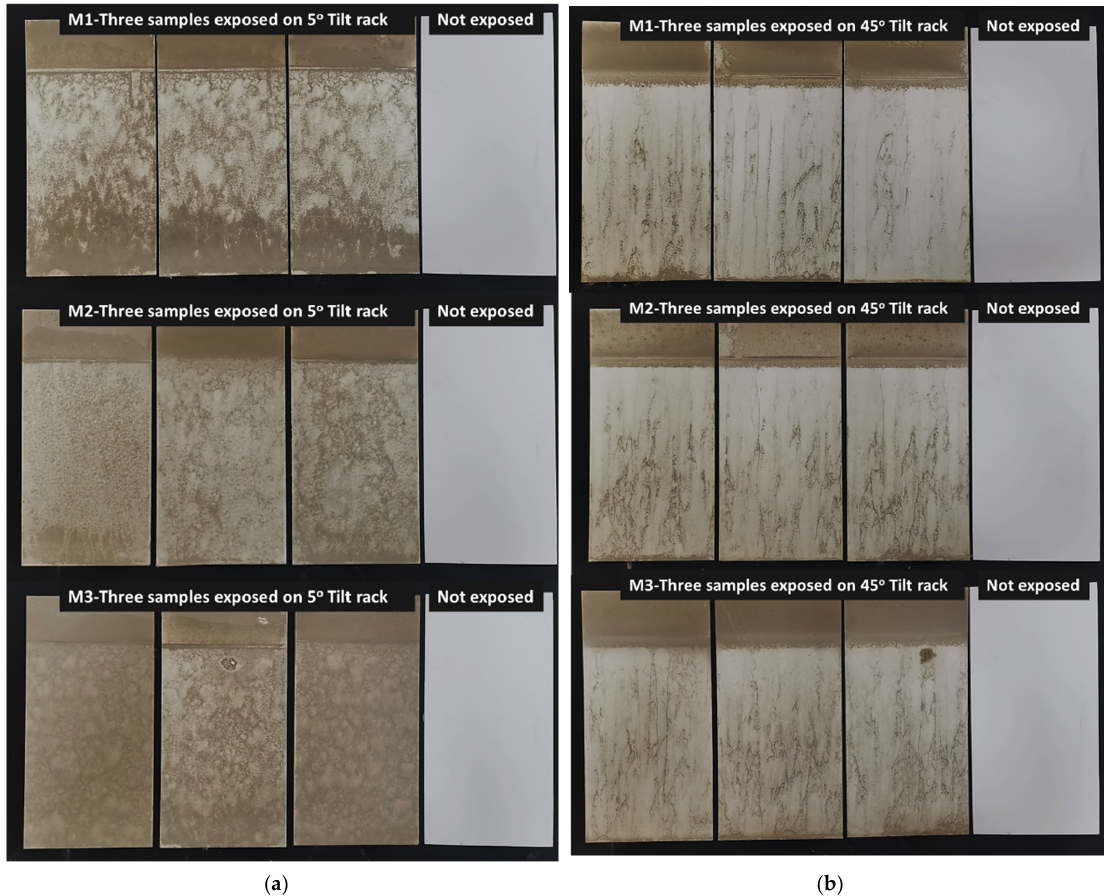
Figure 7. Triplicate samples of various manufacturers after 3 years of natural aging at Ras al Khaimah: ( a ) 5° tilt and ( b ) 45° tilt. ( a ) 5 ◦ tilt and ( b ) 45 ◦